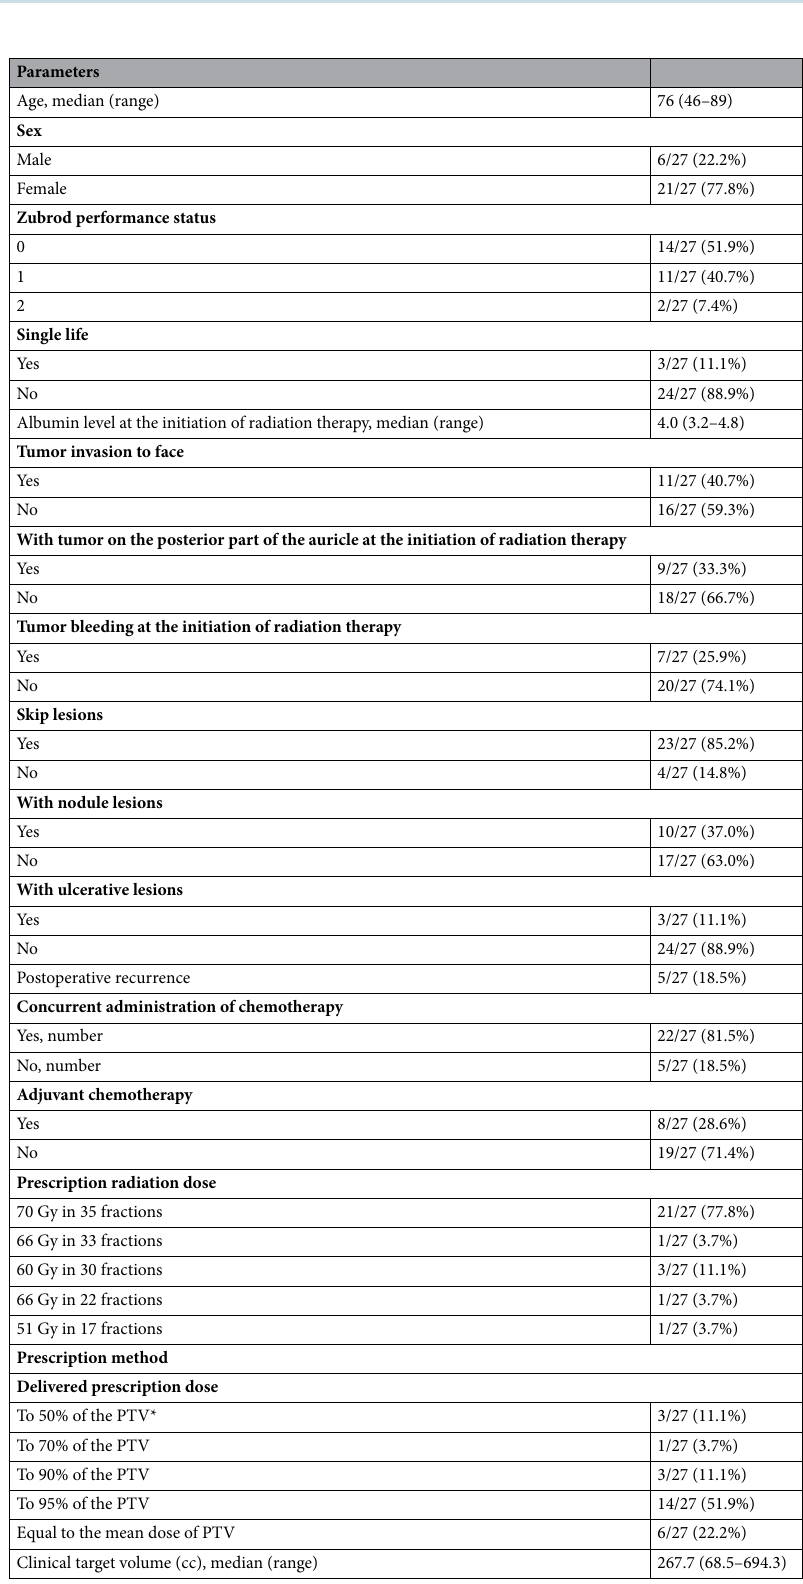
Table 1. Patient and treatment characteristics. PTV*, planning target